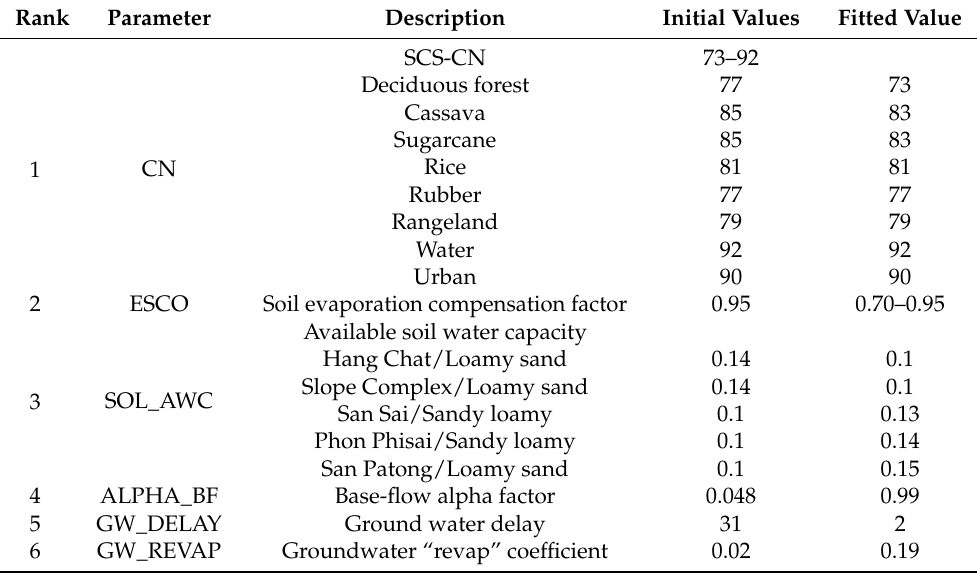
Table 2. Adjusted range of parameters for streamflow calibration and their final values in the HBS [58]. Rank Parameter Description Initial